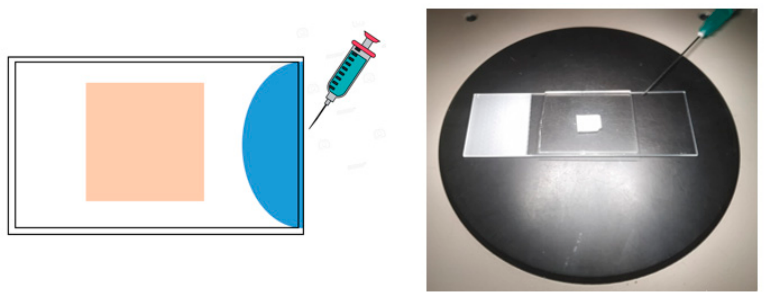
Figure 9. Set up for the dissolution tests.